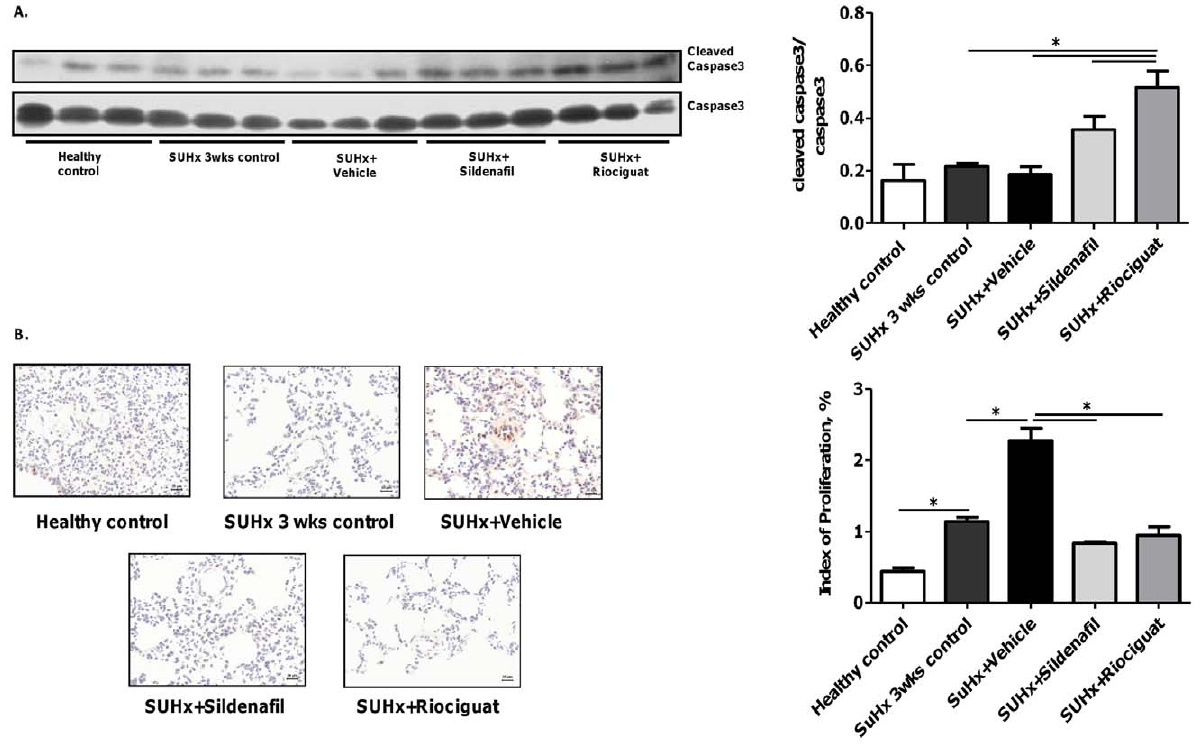
Figure 5. Effects of riociguat and sildenafil on apoptosis and cell proliferation in the lung tissue of SUHx rats. (A) Western blotting of caspase-3 and cleaved caspase-3 with densitometric analysis and (B) PCNA immunostaining with representative examples of different treatment groups. * p , 0.05. Note. PCNA, proliferating cell nuclear antigen.